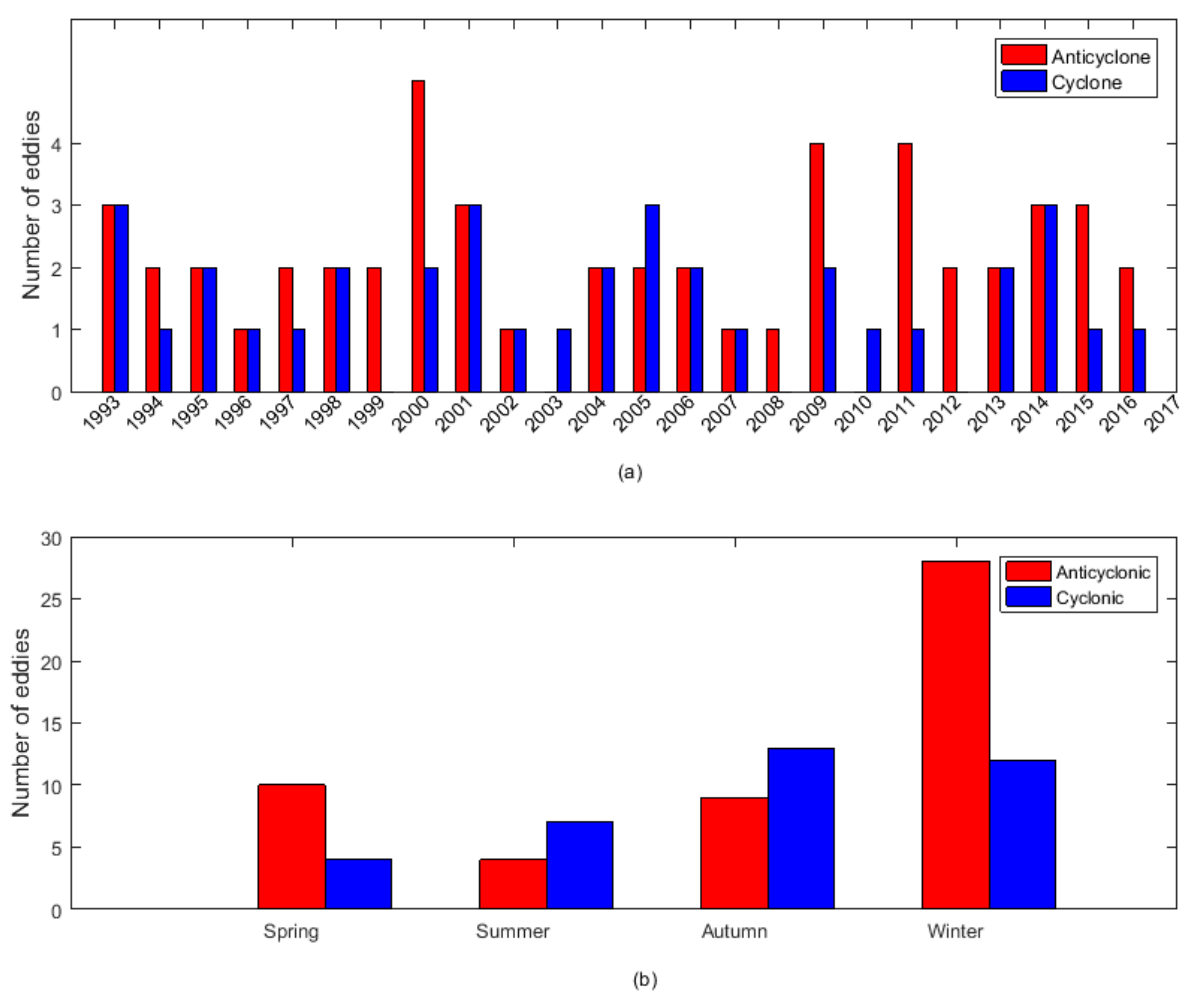
Figure 5. ( a ) Interannual and ( b ) seasonal distribution of the number of the along-the-isobath type. The red columns indicate anticyclonic eddies, and the blue columns indicate cyclonic eddies.